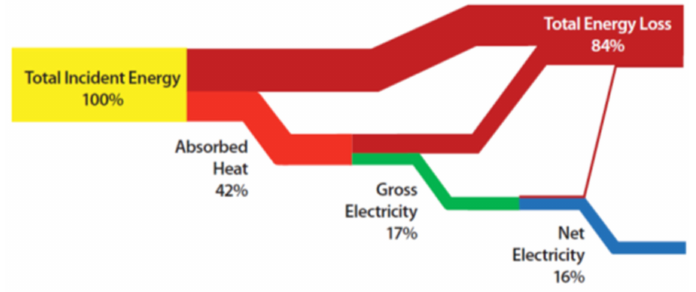
Figure 2. The efficiency of a typical CSP plant